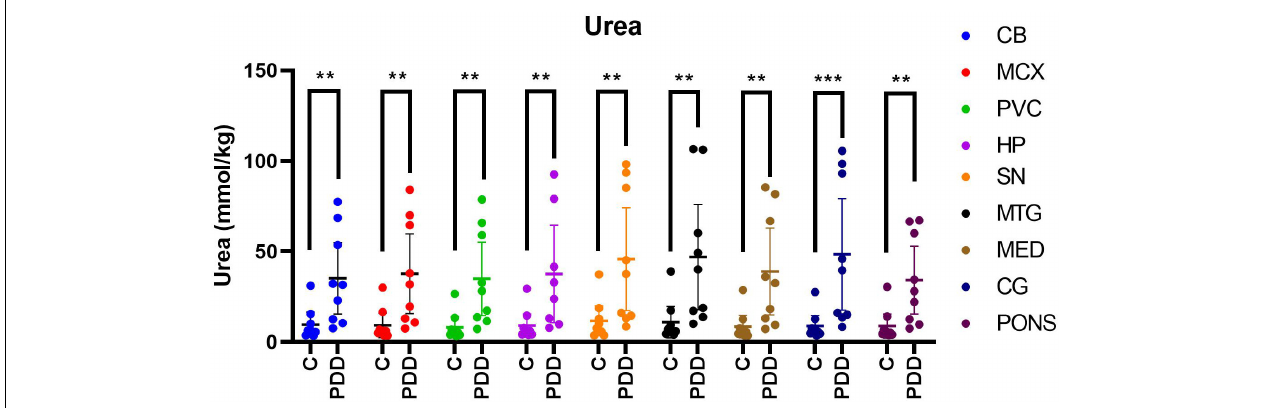
FIGURE 1 | Urea concentrations in PDD cases and matched controls. Mean tissue urea concentrations ± 95% confidence intervals expressed in mmol/kg. Case-control differences were determined by applying the Mann-Whitney- U test. ** p < 0.01 and *** p < 0.001. C, control; PDD, Parkinson’s disease dementia case.